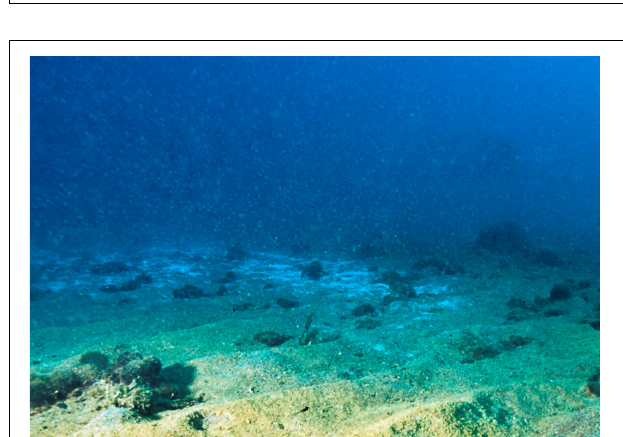
FIGURE 3 | Hydrothermal site with soft bottom covered by a white microbial